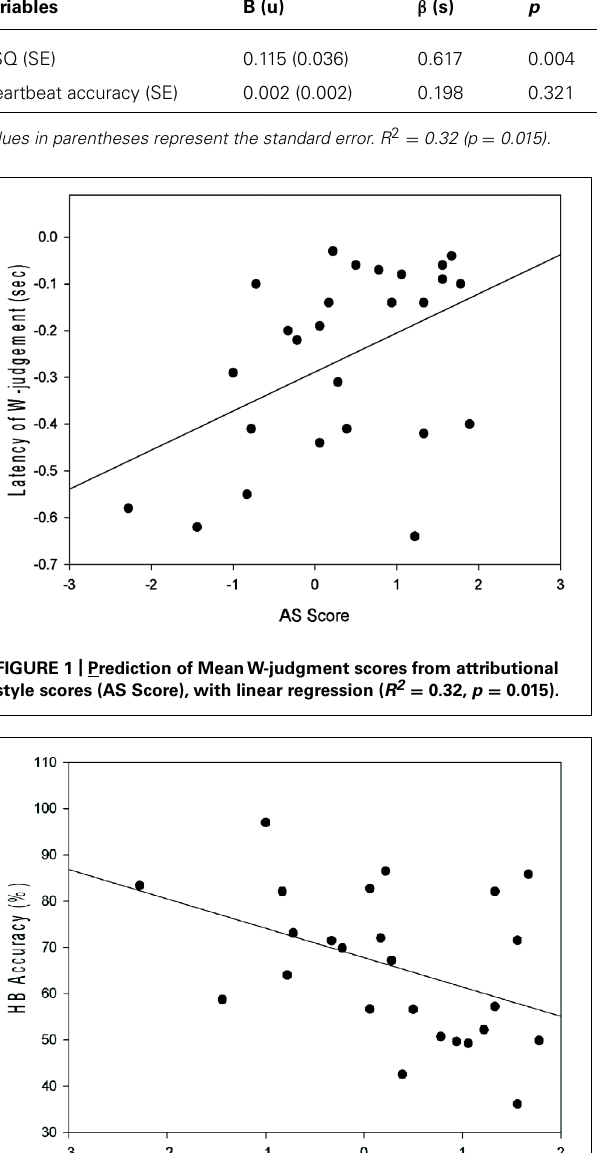
Table 2 |The unstandardised (u) and standardized (s) beta coefficients as predictors ofW-judgment. Variables